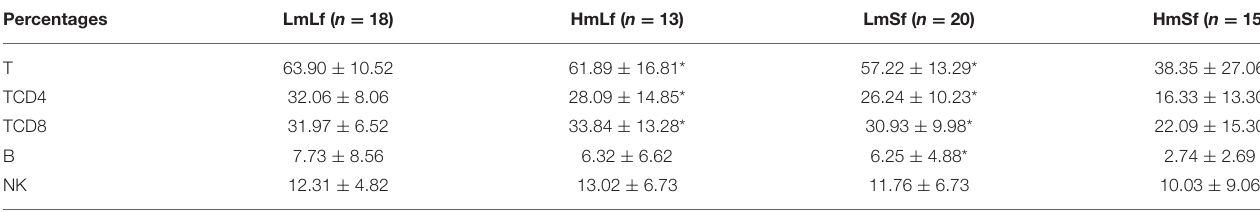
TABLE 2 | Effects of the MELD score and the follow-up period on the percentages of lymphocyte subpopulations following liver transplantation. Percentages LmLf ( n =